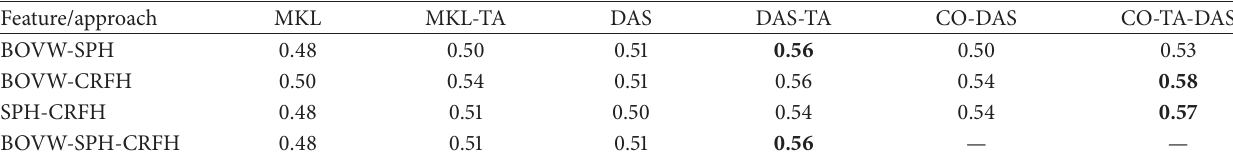
Table 2: IMMED dataset: average accuracy of the multiple feature